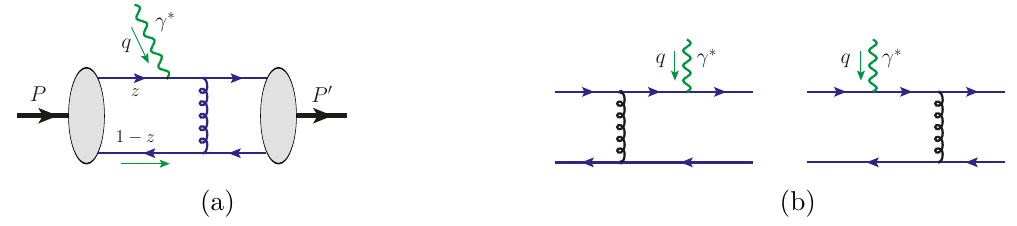
Figure 19. (a) Sketch for pion Form Factor; (b) Leading order Feynman diagrams for the partonic hard part of the factorized pion Form